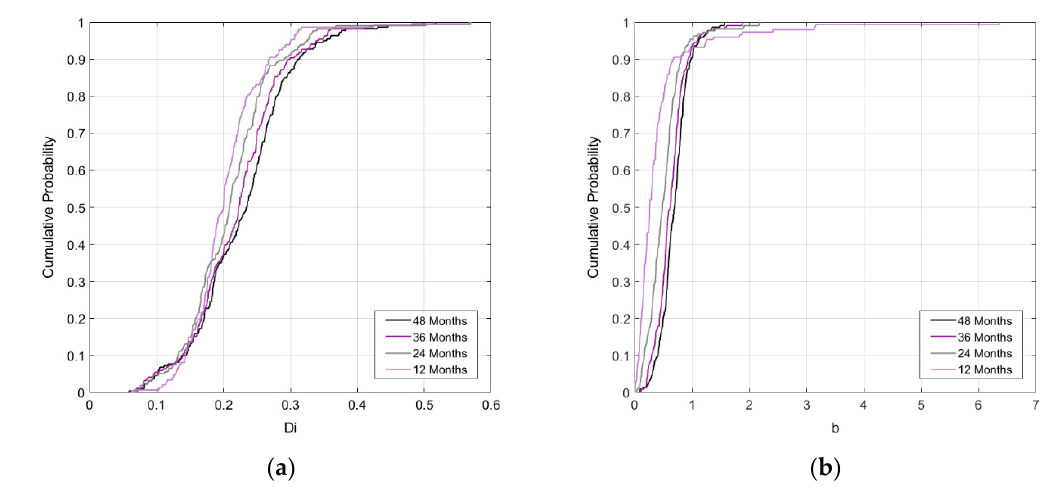
Figure 5. Change of cumulative probability for the DCA parameters according to production period: ( a ) the initial decline rate; ( b ) the decline exponent analysis for